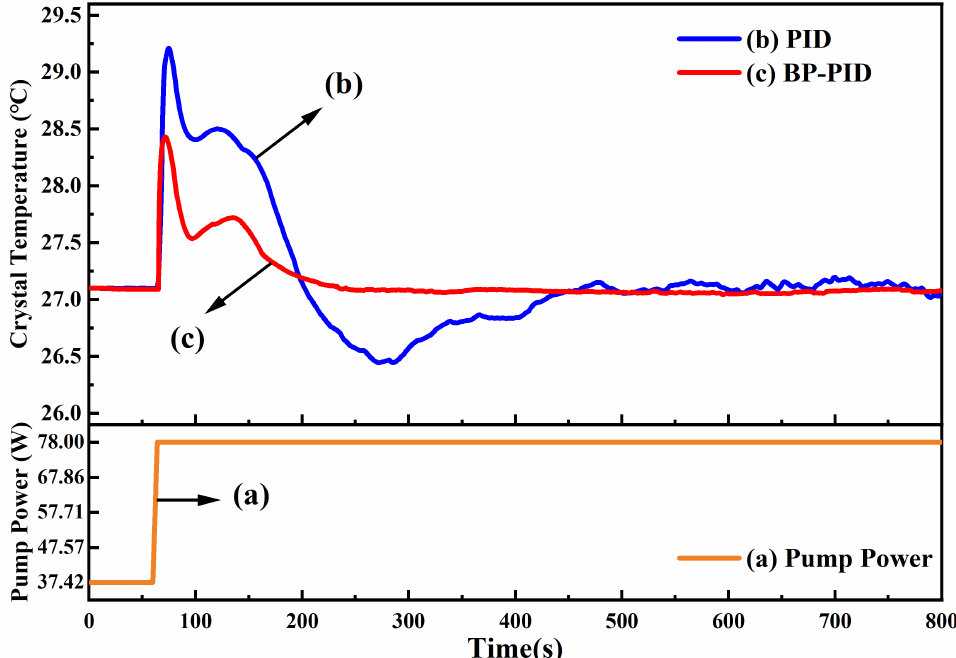
Figure 5. The change of the crystal temperature when the incident pump power increased from the threshold point to the optimal operating point. The orange line (a) was the change of the incident pump power, the blue line (b) was the crystal temperature of using traditional PID controller, and the red line (c) was the crystal temperature of using BP neural network PID